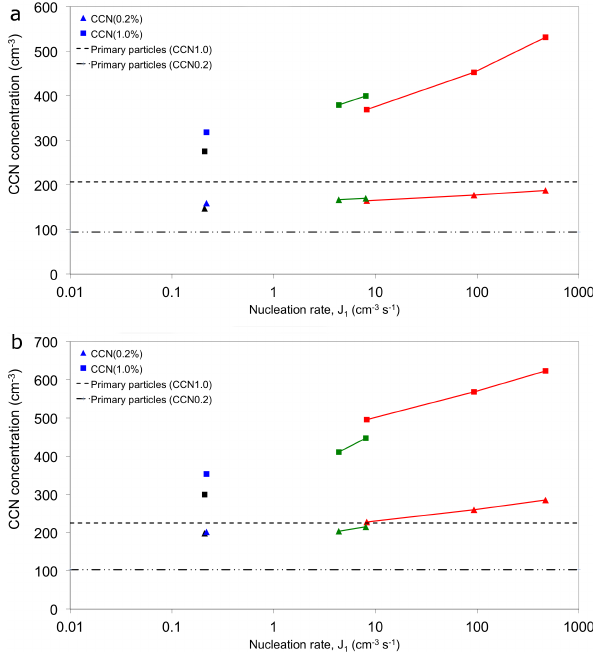
Figure 4. Global average cloud condensation nuclei concentrations in the boundary layer for all nucleation simulations. Squares repre- sent CCN(1.0%), and triangles show CCN(0.2%). Panel (a) shows the base SOA simulation results while (b) shows the high SOA sim- ulation results (extra 100Tgyr − 1 ) . In both panels, the dashed black lines represent the CCN(1.0%) concentrations for the simulation with no nucleation (nominally, primary particle contribution). The dash-dot black lines show the same for CCN(0.2%). Blue lines re- fer to ion nucleation, black is binary, green is activation, and red is